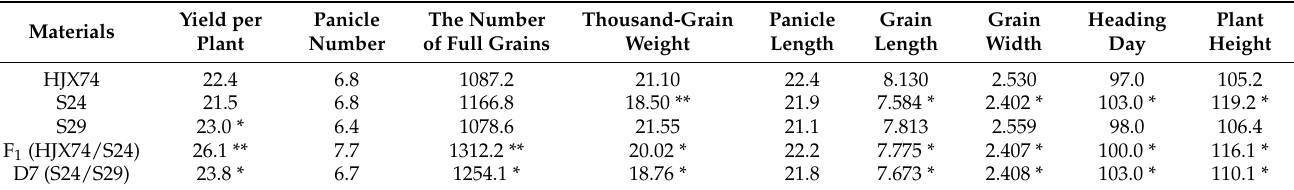
Table 4. Phenotypes of QTLs for grain shape and